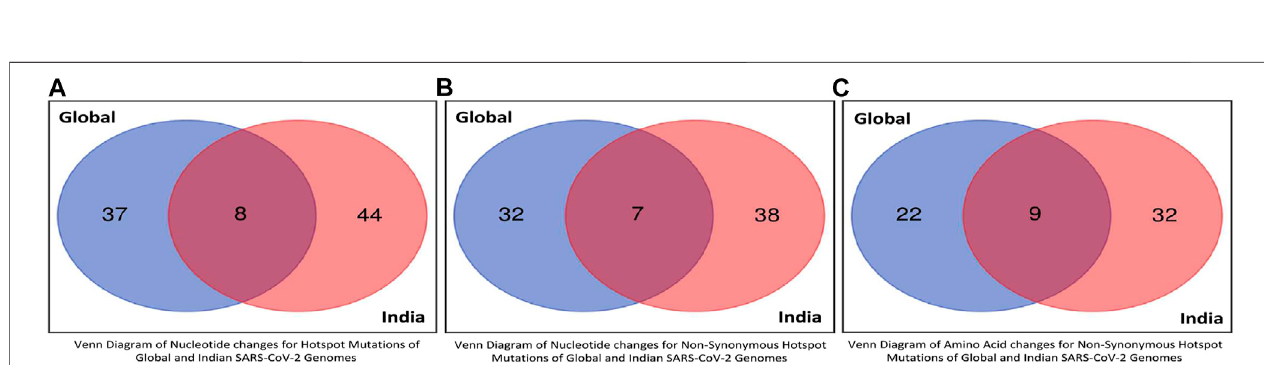
FIGURE 8 | Venn diagrams of global and Indian SARS-CoV-2 genomes to represent common hotspot